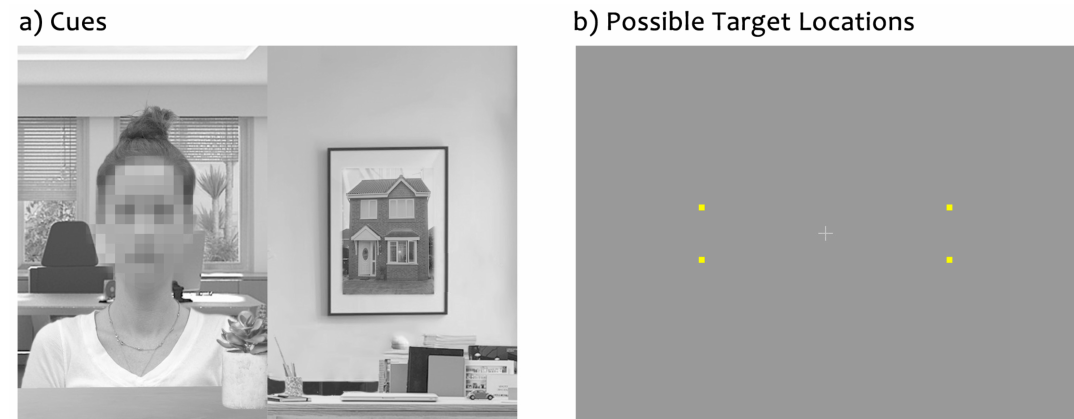
Figure 1. ( a ) The cue screen depicting upright cues with the face in the left visual field. The face has been blurred to preserve the privacy of the actor. ( b ) The target screen depicting all possible target locations for square